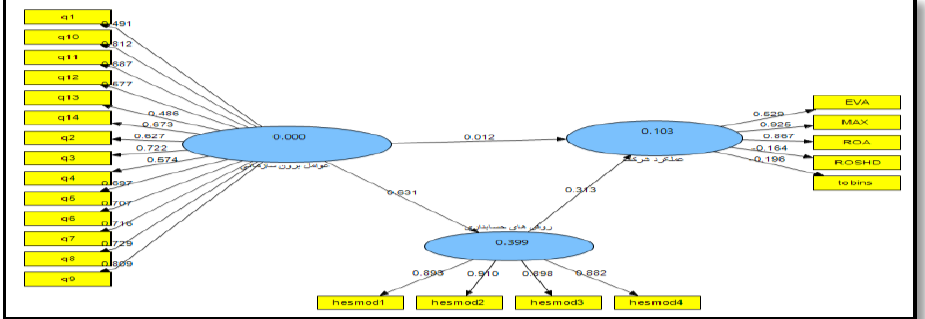
Figure 3. The model path